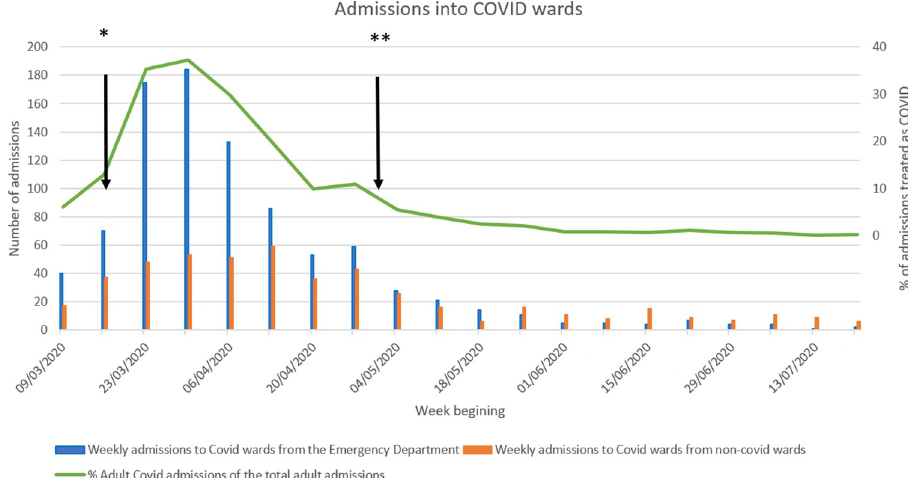
Fig 2. Breakdown of the routes of admission of adult COVID patients into a COVID ward during the initial pandemic. � Start of national UK lockdown. �� Mandatory admissions testing